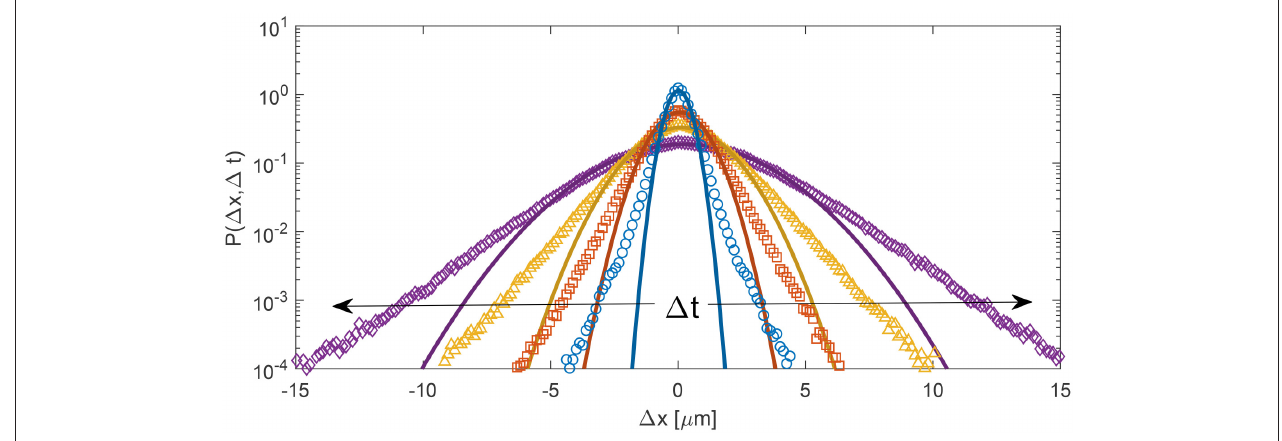
FIGURE 2 | Symbols: PDF P ( 1 x , 1 t ) of cellular displacements for different delay times (blue circles: 1 t = 2 min, orange squares: 1 t = 10 min, yellow triangles: 1 t = 20 min, purple diamonds: 1 t = 40 min) obtained from PT analysis over a time interval of 200 min, about 3 h after the beginning of the experiment. Continuous lines correspond to best fitting Gaussian curves. For all delay times, the PDF displays a marked deviation from a Gaussian behavior, with exponential-like tails.